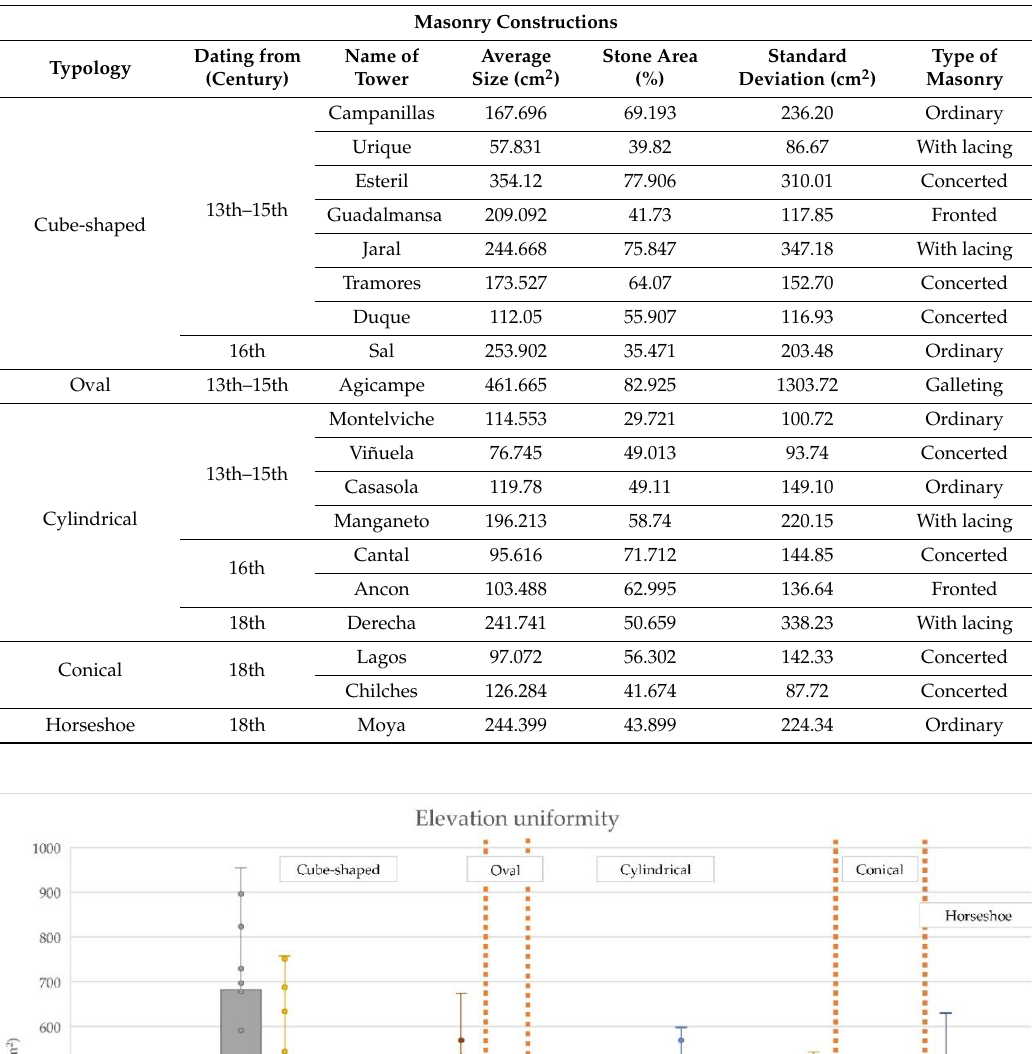
Table 1. Data Related to the Towers Built with Masonry.